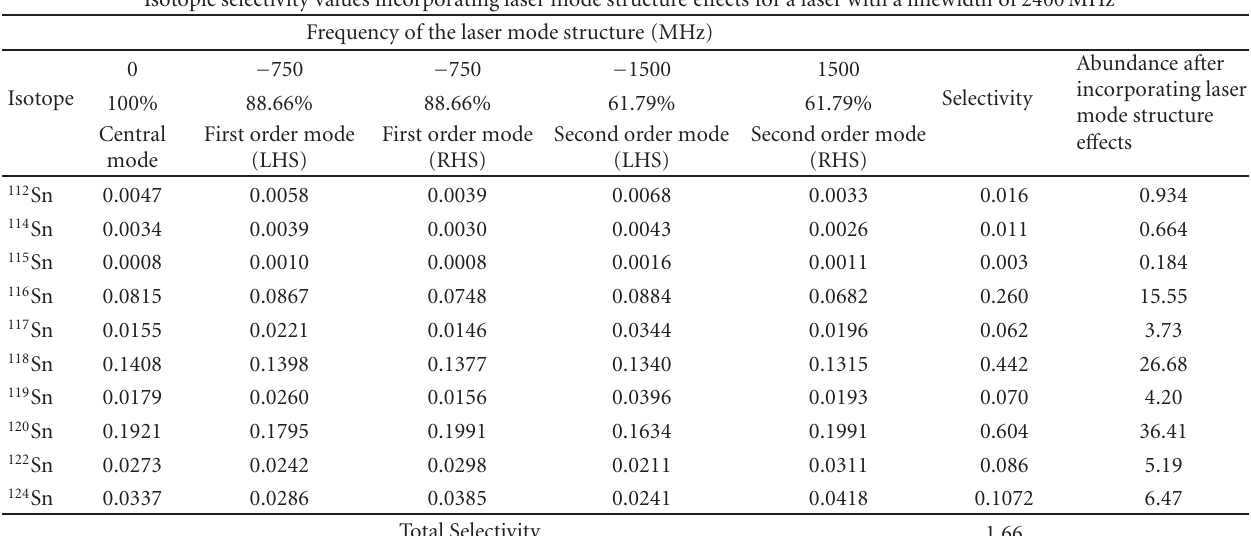
Table 4: A table of theoretically computed isotopic selectivity and abundance values after incorporating laser mode structure e ff ects of a laser with a linewidth of